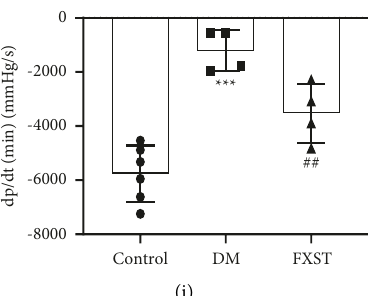
Figure 2: Effects of FXSTon cardiac function in DM rats. The model of DCM was induced by intraperitoneal injection of 65mg/kg STZ and the related parameters were determined by hemodynamic and echocardiography assays 12 weeks later. (a) Representative images of cardiac echocardiogram. (b) EF, (c) FS, (d) LVSP, (e) LVEDP, (f) Heart rate, (g) CI, (h) dp/dt max, and (i) dp/dt min were detected. Data are expressed as the mean SD ( n 4–6 for each group). (cid:31) ±